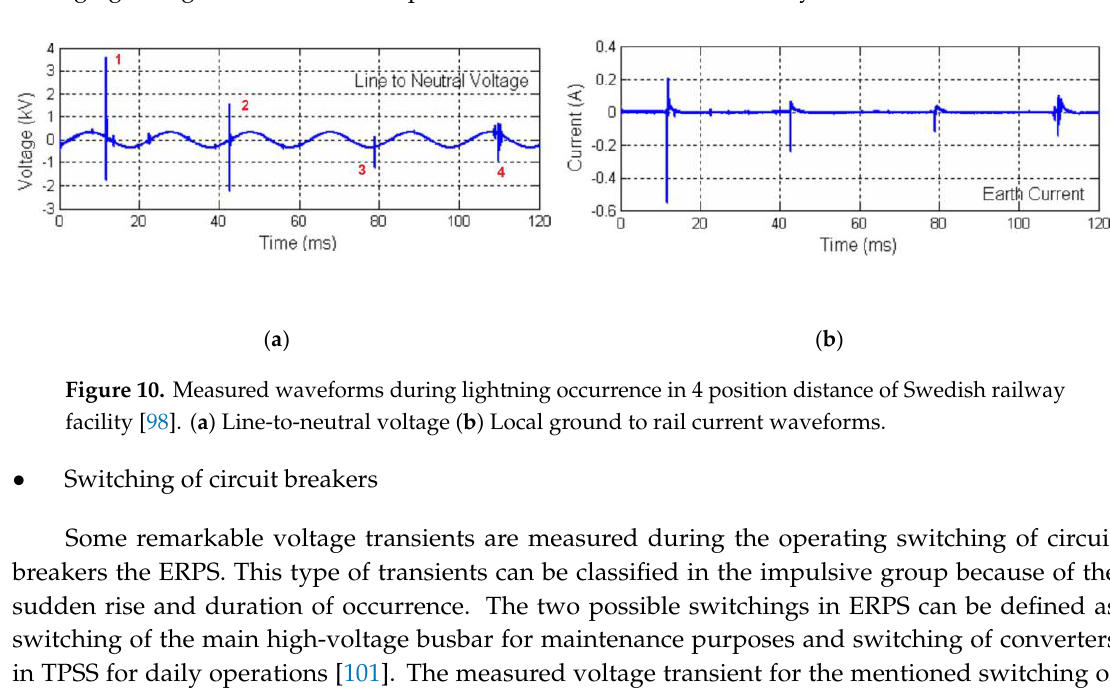
( b ) Figure 12. Measured transient voltage in 3 kV DC Italian ERPS [102]. ( a ) Caused by sudden generated tractive effort. ( b ) Caused by passing neutral section and changing supplying TPSS. 2.4.2. Oscillatory Transients (OsT) The OsT is an abrupt, and non-power frequency variation of the steady-state situation of voltage/current, which is usually bidirectional in polarity. OsT includes a waveform with instantaneous amount changes of polarity quickly for several times and commonly declining within a fundamental-frequency period. It is specified by the amplitude, spectral content, and duration times. They can be classified into three groups of low (<5 kHz), medium (5–500 kHz), and high (0.5– 5 MHz) frequency oscillations [96]. The most popular reason for the occurrence of OsT in ERPS are as follows: